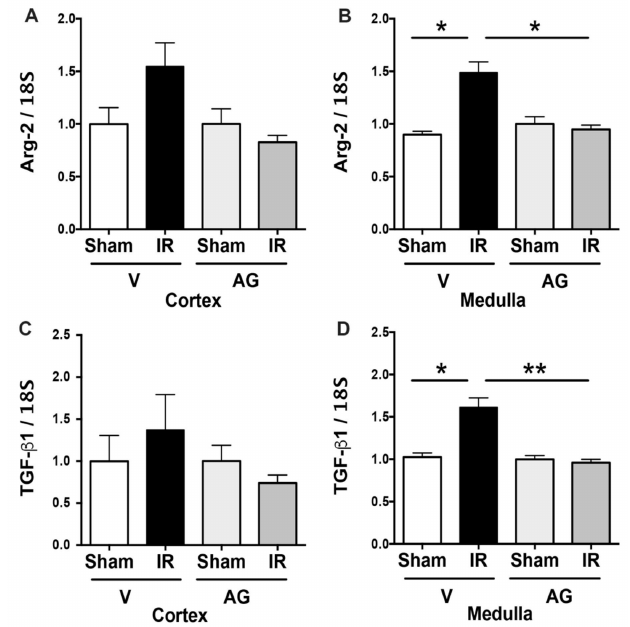
Figure 4. AG inhibited the upregulation of Arg-2 and TGF- β 1 mRNA observed during IR. BALB/c mice were treated with either vehicle or AG (50 mg/kg i.p) before sham or subjected to 30 min of ischemia and 48 h of reperfusion (IR). The Arg-2 and the TGF- β 1 mRNA expressions were determined by qPCR in sham (n = 5), IR (n = 5), AG-sham (n = 6), and AG-IR (n = 6). ( A ) Arg-2 mRNA in the cortex. ( B ) Arg-2 mRNA in the medulla. ( C ) TGF- β 1 mRNA in the cortex ( D ) TGF- β 1 mRNA in the medulla. The bar graphs represent mean ± SEM, and the data were analyzed using ANOVA and Kruskal–Wallis test. * p < 0.05, ** p <